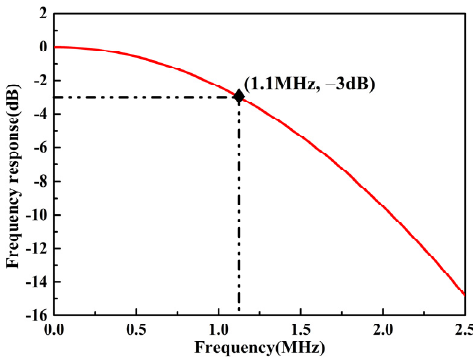
Figure 4. The simulated frequency response curve of the FOAS. In the sensing process of the FOAS, the change in the air refractive index caused by the sound pressure results in a shift of the resonance frequency, which is proportional to the change in sound pressure. Since the frequency difference generated by the resonance frequency shift of the FPE is very weak, it is difficult to be measured directly. Phase modulation spectroscopy technology is used as the acoustic demodulation method for the detection of acoustic signals. The weak frequency difference signal can be amplified and extracted by means of phase modulation and lock-in amplification technology. Then, according to the correspondence relationship between the resonance frequency shift and the demodulated curve, the demodulated curve is used as an error signal to feedback and control the laser so that the laser frequency can track and be locked at the resonance frequency. After frequency locking, the effect of the acoustic signals on the resonance frequency corresponds to the offset of the locked demodulated curve relating to the null point. The working principle of the light field and electric field in the detection process of phase modulation spectroscopy technology has been analyzed in detail in our previous work. According to Equation (5) of Reference [34], the demodulated curves of FPE with different reflectivity can be simulated, as shown in Figure 5. Figure 5 illustrates that the greater the reflectivity of the FPE, the greater the slope of the demodulated curve. For a given resonance frequency offset, the amount of change in the linear amplitude of the demodulated curve, that is, the sensitivity of the FOAS, depends on the slope of the demodulated curve. Therefore, the sensitivity of the FOAS based on FPE with high reflectivity will be greater.